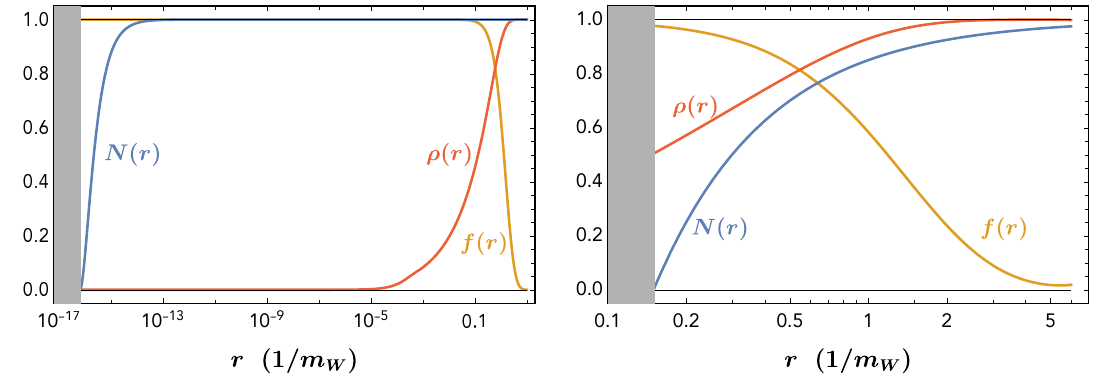
Figure 1 . Profiles as a function of r for the SM hairy magnetic black holes. Left: the horizon √ r H = c W 4 π/ ( e M pl ) for an extremal black hole. Right: a larger horizon with r H = 0 . 15 /m W with the Higgs vacuum expectation value (VEV) profile ρ ( r ) to be half-restored at the horizon. Not shown here is the profile for P ( r ) , which is approximately one because of P 0 /P = O ( Gv 2 ) and P ( ∞ ) = 1